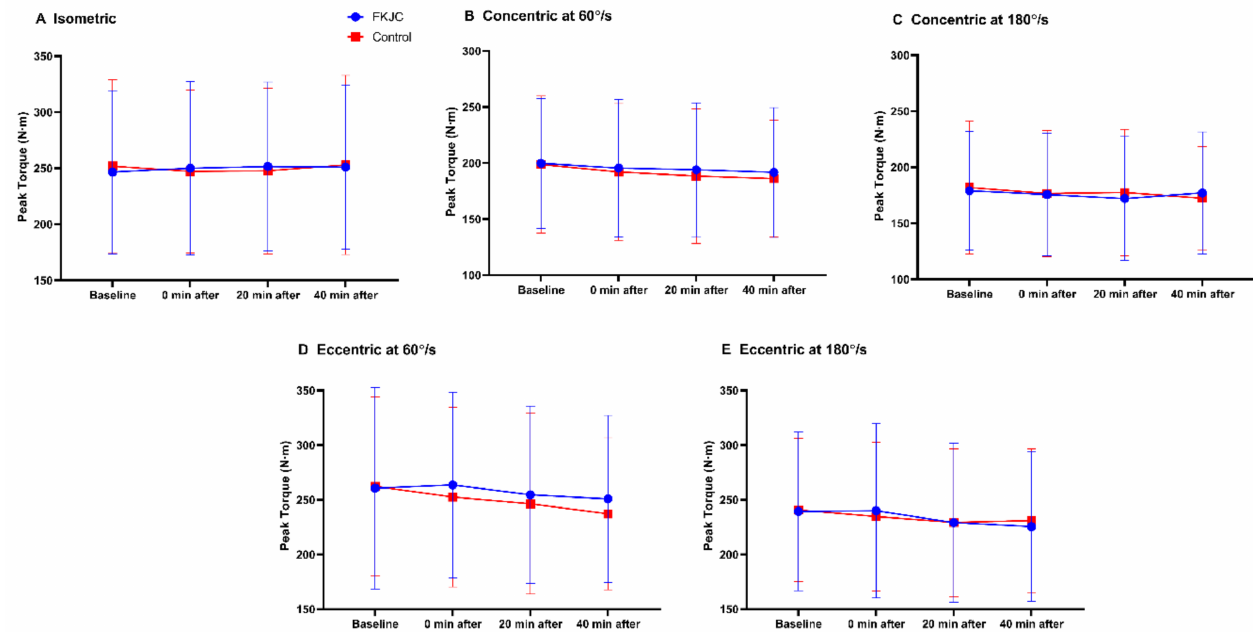
Figure 4. Peak torque data during different modes of quadriceps contractions at baseline, and immediately, 20 min, and 40 min after FKJC (blue) and control (red) condition. FKJC, focal knee joint cooling. ( A ) Isometric, ( B ) Concentric at 60 ◦ /s, ( C ) Concentric at 180 ◦ /s, ( D ) Eccentric at 60 ◦ /s, ( E ) Eccentric at 180 ◦ /s. Data are presented as mean ± standard